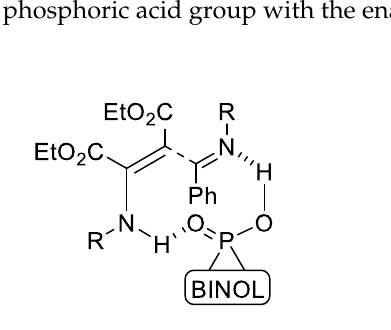
Figure 3. Transition state proposed for the Mannich reaction in the three-component reaction.